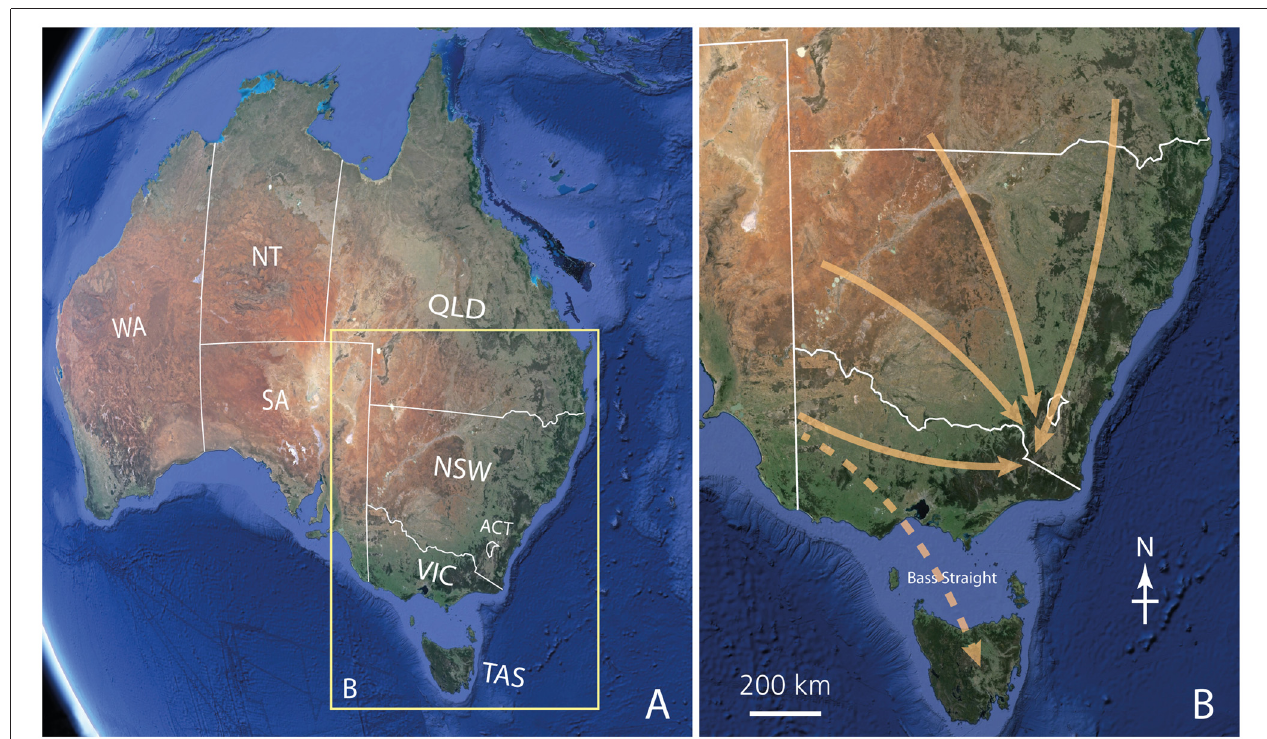
FIGURE 2 | The migratory routes of Bogong moths. (A) A map of Australia showing the Australian States and Territories (WA, Western Australia; SA, South Australia; NT, Northern Territory; QLD, Queensland; NSW, New South Wales; ACT, Australian Capital Territory (the location of the national capital Canberra), VIC, Victoria; TAS, Tasmania). The yellow box shows the region of Australia shown in (B). (B) The likely migratory routes of Bogong moths during the spring migration (the autumn migration occurs in the reverse direction). Arrows show the migration of moths to the alpine regions of NSW, the ACT and Victoria from southern Queensland, western and northwestern NSW and western Victoria. Some moths, blown from western Victoria by northwesterly prefrontal winds, even cross Bass Straight to arrive in Tasmania (where they either breed or estivate, returning to Victoria during what appears to be a reverse migration in autumn). Because we are currently unsure whether this is a true migration or an accidental displacement by winds, the Tasmanian arrow is shown as dashed . Images taken from Google